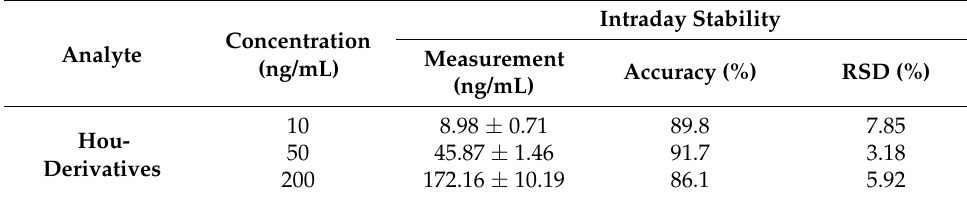
Table 4. Stability results of Hou derivatives in plasma ( n = 6).